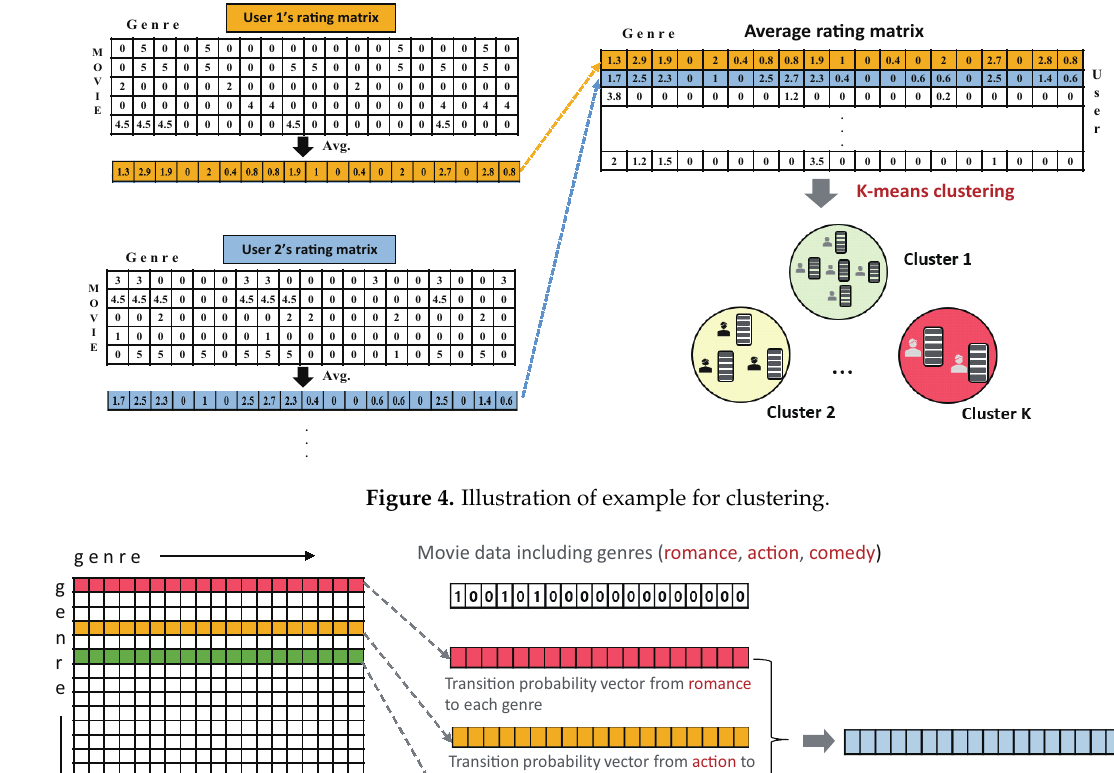
Figure 5. Transition probability matrix and average transition probability